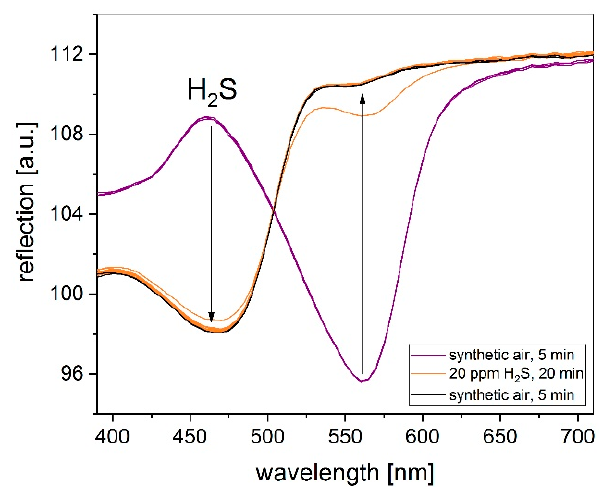
Figure 3. Reflection spectra of Cu-PAN layers on PE foil exposed to 20 ppm H 2 S in synthetic air and a relative humidity of 40% at room temperature. Recording of 15 measurement cycles with a time lag of two minutes,